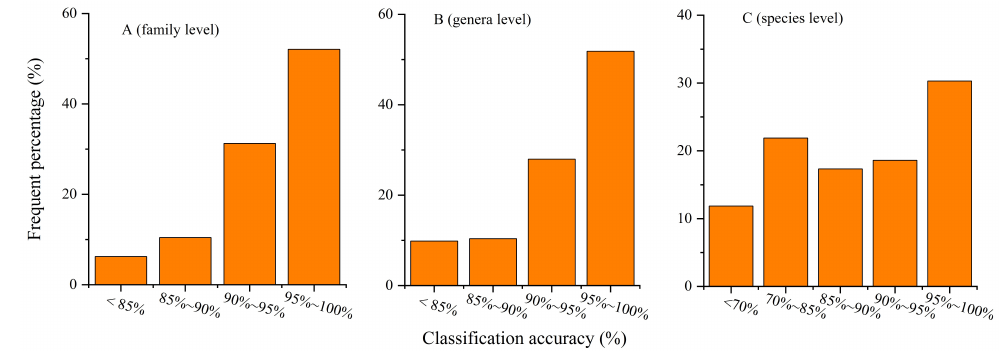
Figure 4. Classification accuracy at the three bird taxonomic levels of family, genus and species in